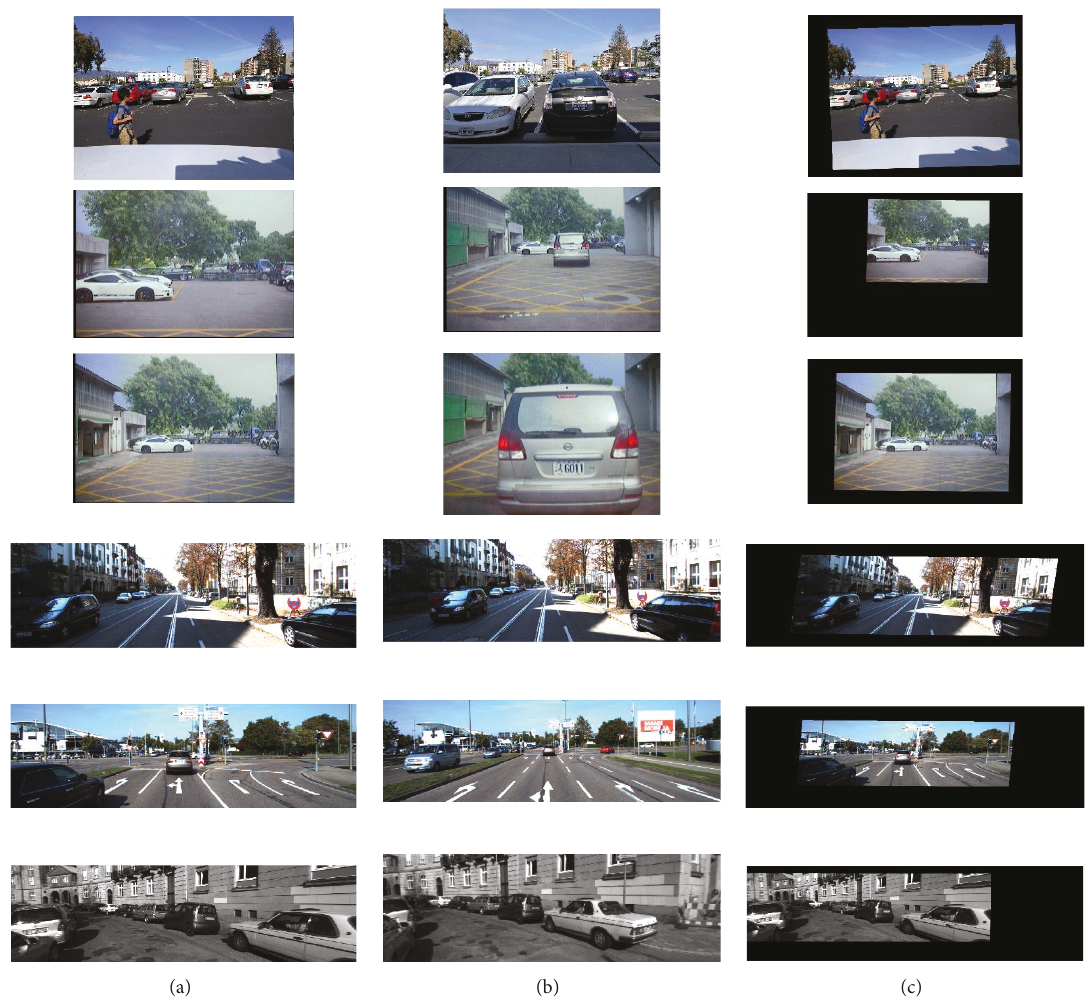
Figure 8: Affine transformation results based on front and back vehicle